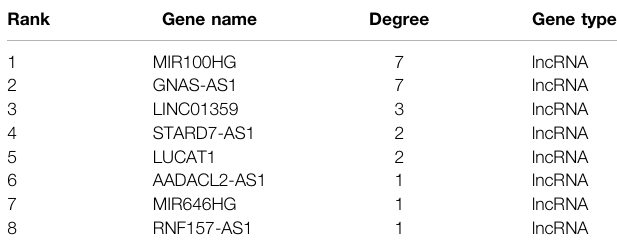
( Figure 7B ). The lncRNA LINC01359-miRNA-mRNA subnetwork consistedofone lncRNAnode,threemiRNAnodes,16mRNAnodes,